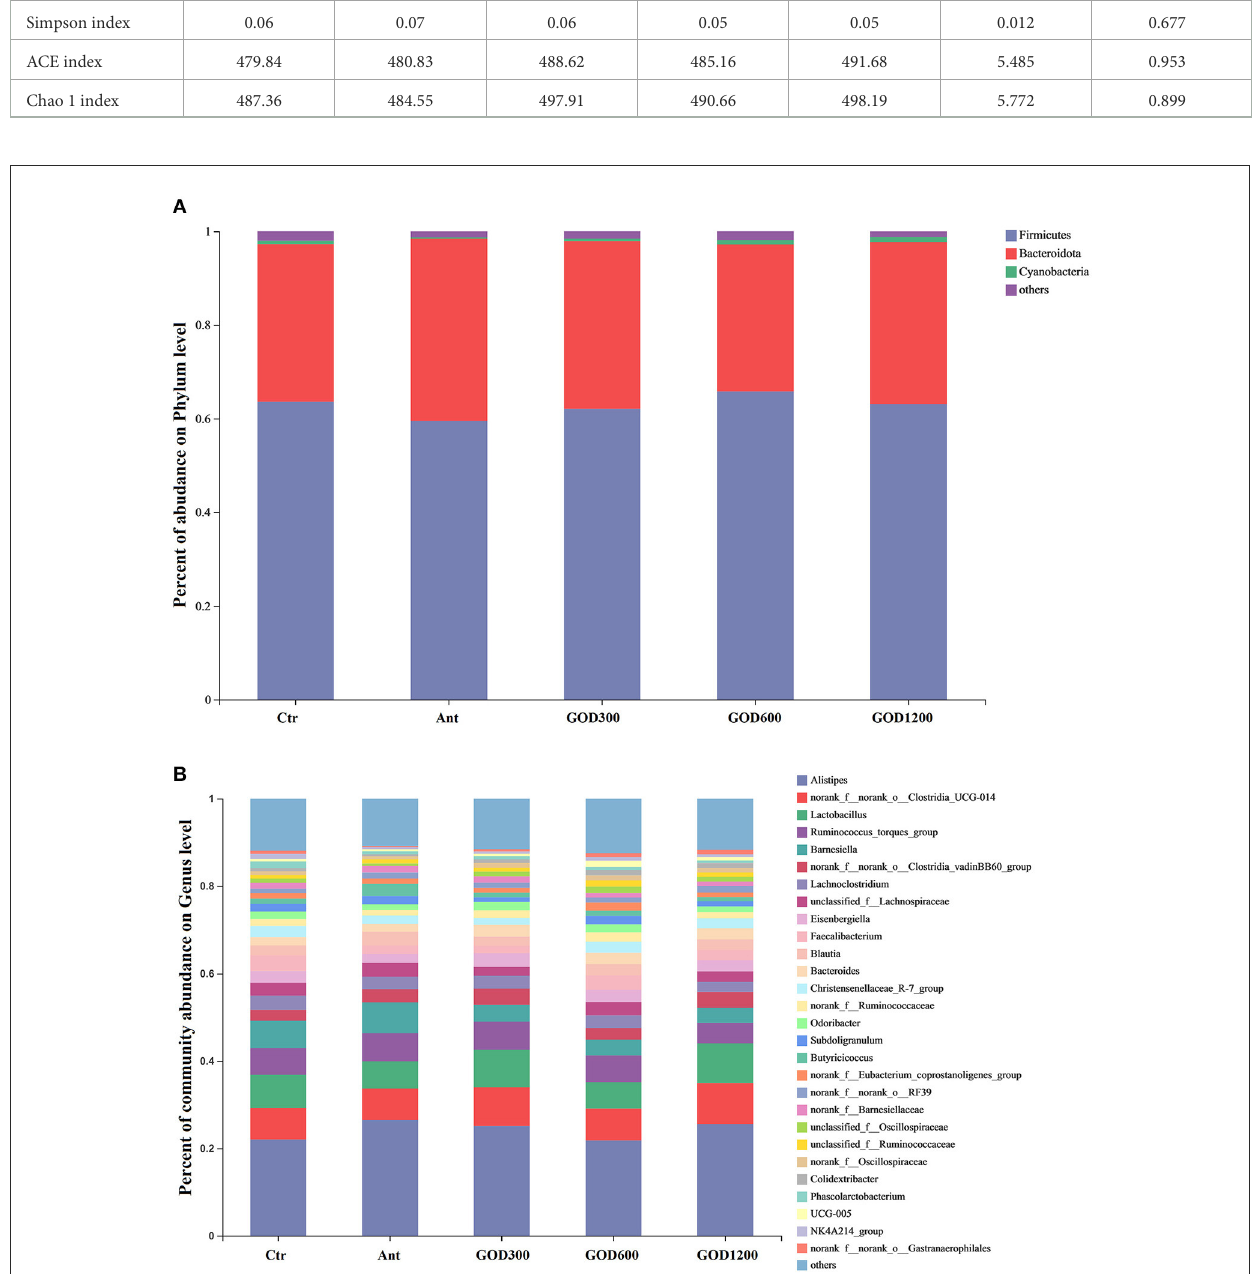
FIGURE3 Compositions of cecal microbiota identified under different concentrations of GOD and the antibiotic-supplied diet on day 42 of the broilers at phylum (A) and genus levels (B) ( n = 6, P < 0.05). Ctr, negative control fed with the basal diets; Ant, positive control fed with the basal diets added 50 mg/kg aureomycin; GOD300, GOD600, and GOD1200, the basal diets supplied with 300, 600, and 1,200 U/kg glucose oxidase, respectively. Ctr, negative control group fed with the basal diets; Ant, positive control group fed with the basal diets added 50 mg/kg